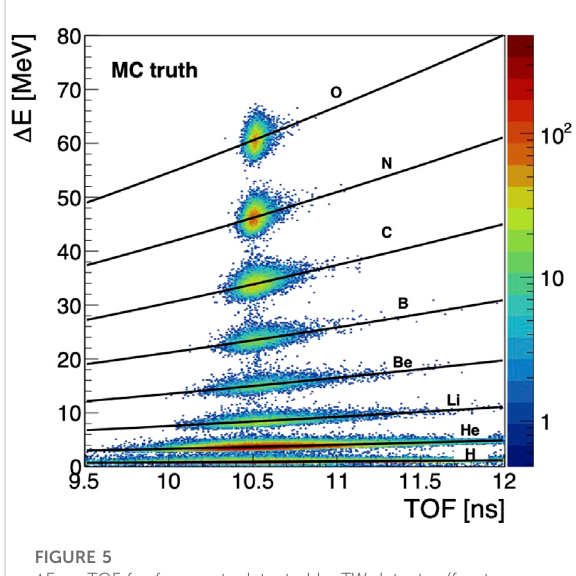
FIGURE 5 Δ E vs. TOF for fragments detected by TW detector (front layer)usingtheMonteCarlotruthinformationfromasimulationof a 400 MeV/u 16 O beam interacting with a C target. Only primary fragments, produced in the target by an inelastic interaction of the incoming beam particles, are